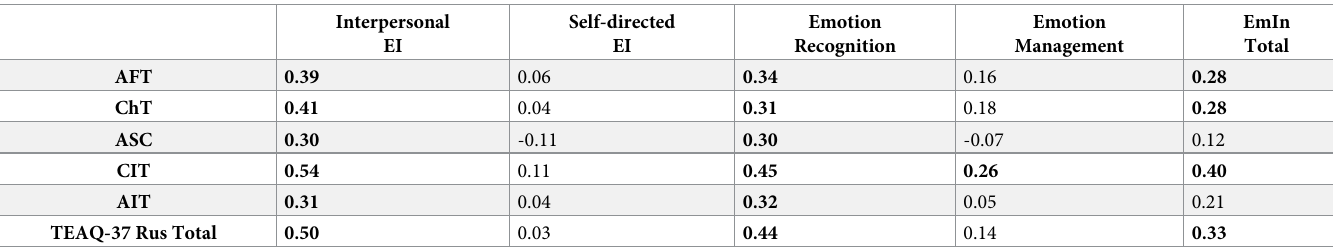
expectations, there was a very strong preference of slow strokes compared to fast strokes, and a somewhat smaller but still a very significant preference for slow strokes over static touch for all the sites with hairy skin (for all post hoc comparisons p < .001). In terms of TEAQ-37 Rus group-related effects there was a highly significant effect of Group (F(1, 323) = 27.08, p < 0.001, η 2 = 0.08) and an interaction Group � Velocity (F(2, 646) = 8.68, p 0.03). Post-hoc comparisons (Fig 3) indicate that, as predicted, participants with higher